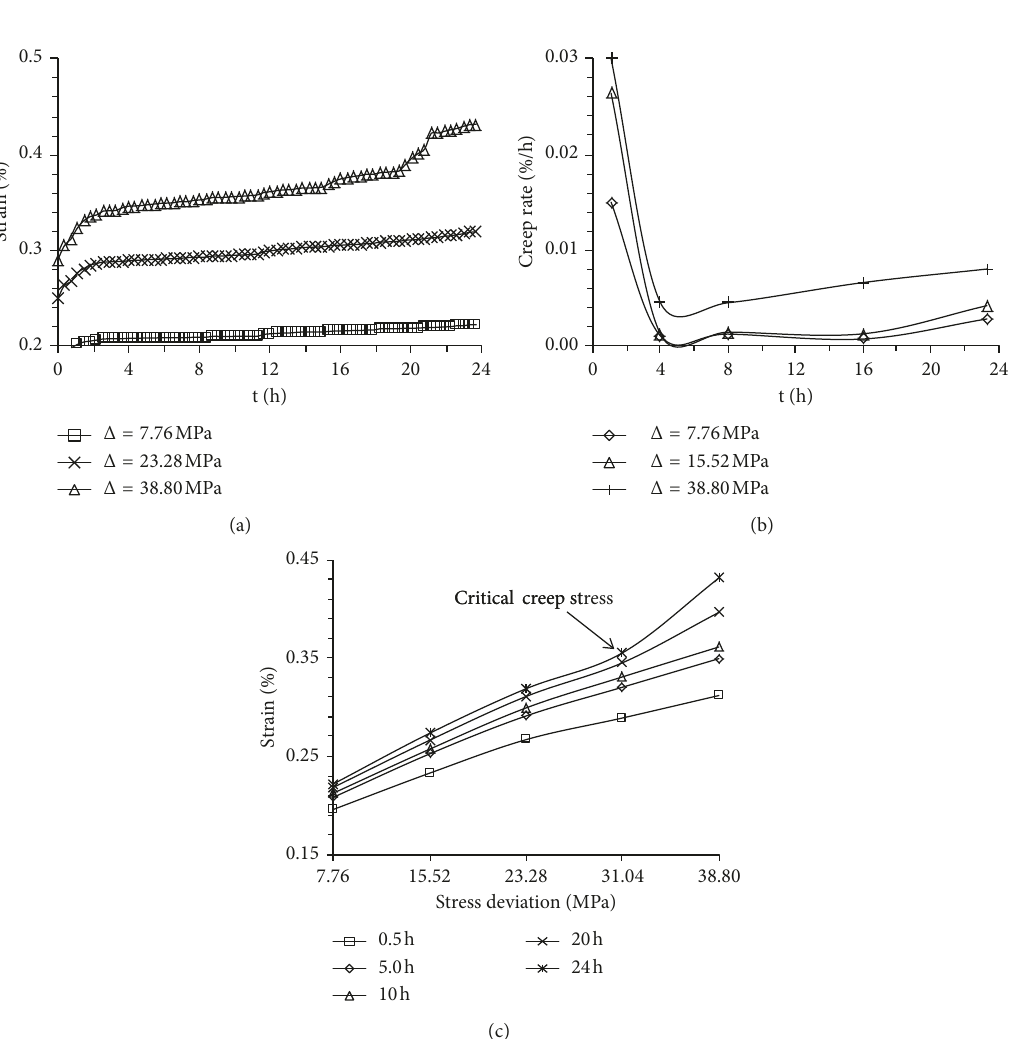
4, T 30 ° C). (a) Strain-time curves. (b) Creep rate-time (cid:30) (cid:30) 4 and T 30 ° C. (cid:30) (cid:30) Model